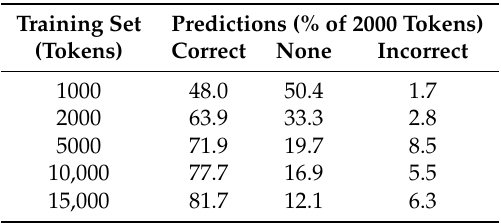
Table 1. Evaluating dictionary-based morphological pre-annotation on